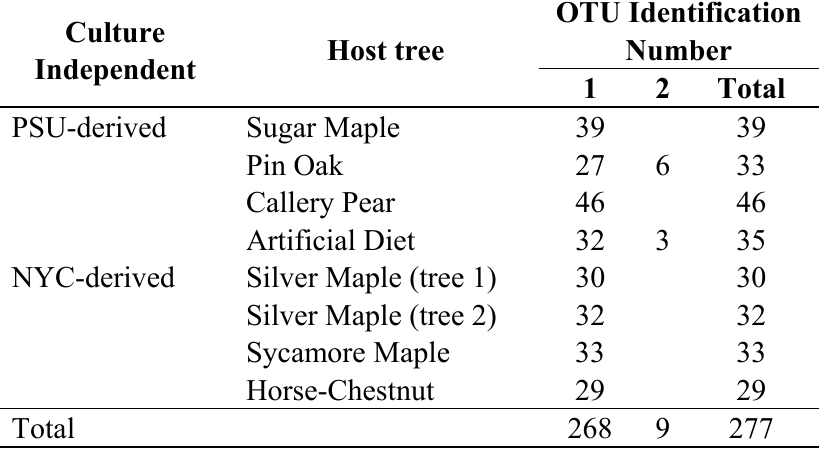
Table 2. Distribution of culture independent TEF1- α clones from PSU colony- and NYC-derived larvae into Operational Taxonomic Units (OTUs). All 277 sequences clustered into two distinct OTUs. OTU1 was the most abundant OTU as it was detected in all NYC- and all PSU-derived samples. OTU2 was not detected in any of the NYC samples, but was detected in a subset of the PSU